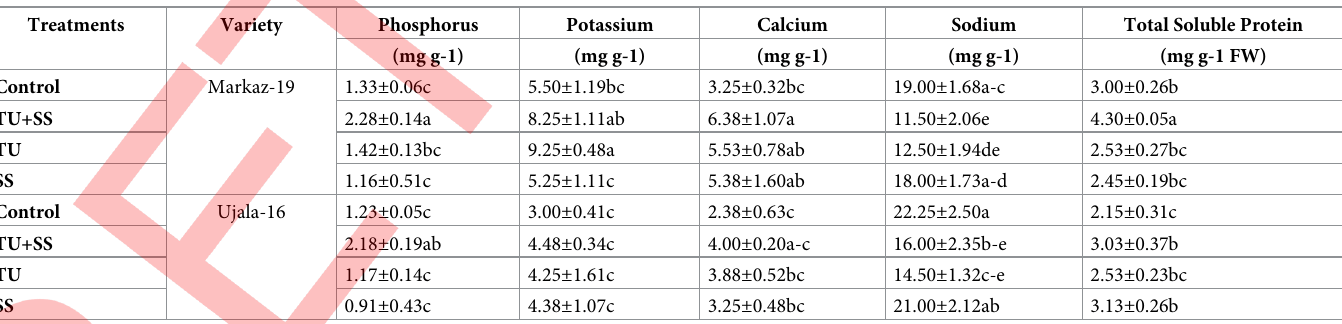
Table 1. Effect of different treatments on ionic contents like sodium, calcium, potassium, phosphorous and soluble proteins constituents of two wheat genotypes (Markaz 19 and Ujala 16) after 35 d of the growth period in pots. Treatments